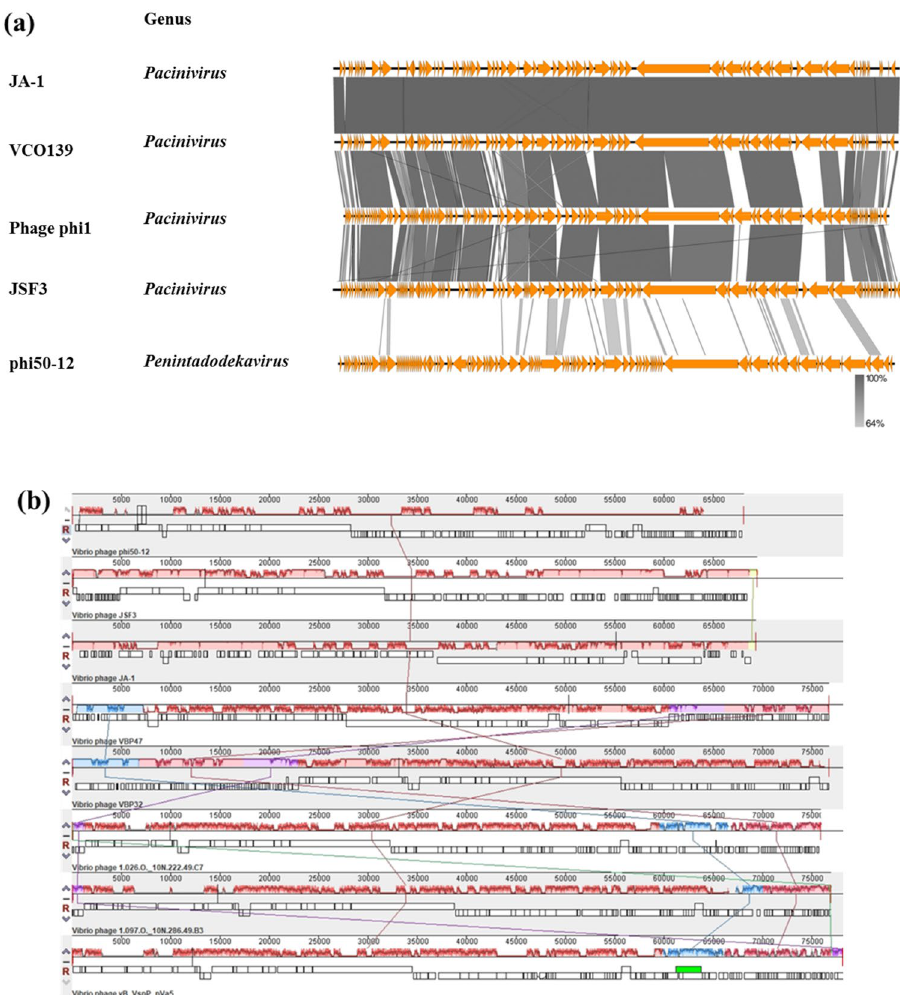
Figure 6. Comparative genomic analysis of N4-like Vibrio phages. ( a ) TBLASTX was performed by Easyfig. All the phages belong to N4-like Vibrio phages. “Genus” represents the taxonomy to which they belong. The similarity range is indicated by the gradient scale. ( b ) Mauve alignment of selected N4-like Vibrio phages infecting a variety of Vibrio hosts. The hosts include V. owensii (phi50-12), V. cholera (JSF3, JA-1), V. parahaemolyticus (VBP47, VBP32), unidentified hosts ( Vibrio phage 1.026.O._10N222.49.C7, 1.097.O._10N.286.49.B3), Vibrio splendidus (vB_VspP_pVa5). Each colored block represents a region of collinear sequence (LCB, local collinear block) among genomes. White boxes represent the ORFs of each genome and their